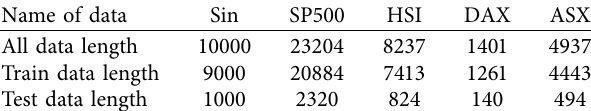
Table 5: The length of the experiment data.